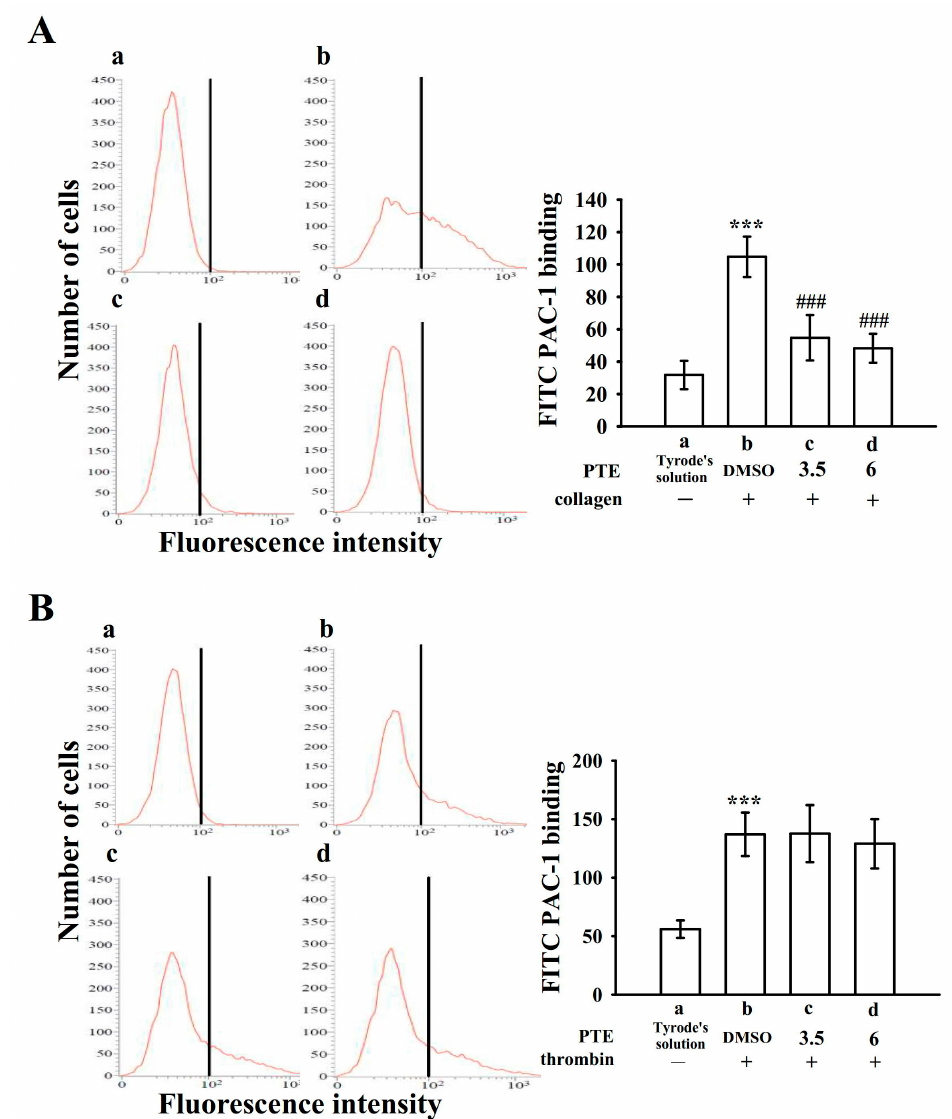
Figure 3. Inhibitory property of pterostilbene (PTE) in integrin α IIb β 3 activation stimulated by either collagen or thrombin. For the flow cytometry analysis, resting platelets ( a ) or platelets were preincubated with the solvent control ( b , 0.1% DMSO) or PTE ( c , 3.5 µ M; d , 6 µ M), and fluorescein isothiocyanate-conjugated anti-PAC-1 mAb (2 µ g/mL) was added before the addition of ( A ) collagen (1 µ g/mL) or ( B ) thrombin (0.01 U/mL). Data are presented as the mean ± standard deviation ( n = 4). *** p < 0.001, compared with the resting control; ### p < 0.001, compared with the 0.1% DMSO-treated group.